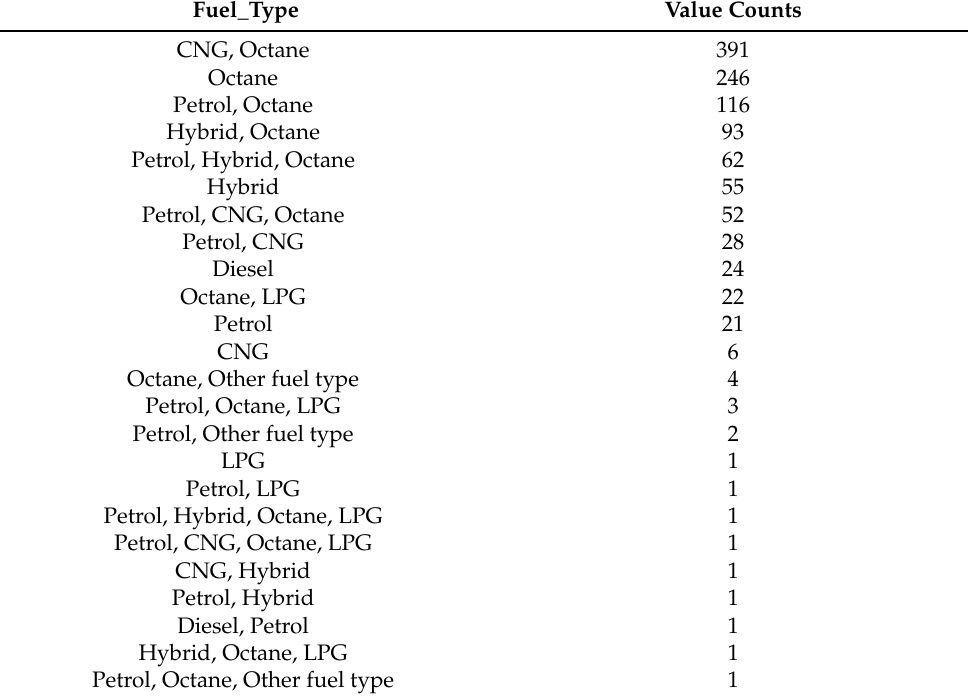
Table 4. Before processing the feature fuel type.